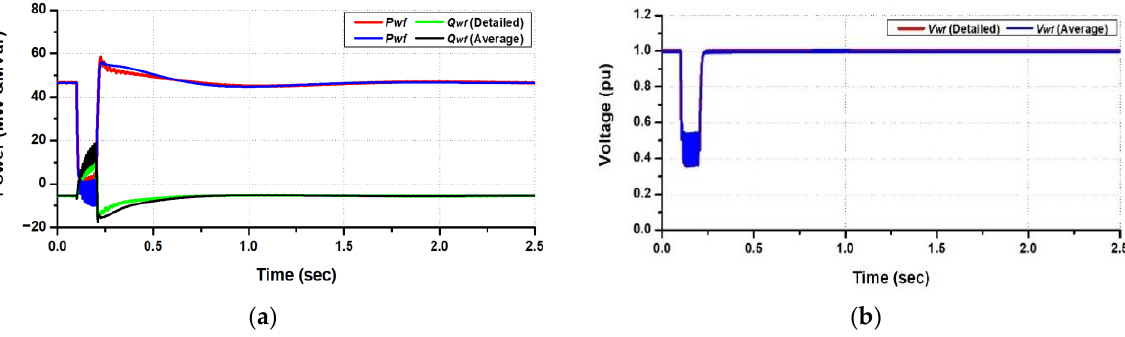
Figure 24. Power output and voltage performances of the wind farm at Bus B33 under the 2LG case: ( a ) Active power output of wind farm; ( b ) Voltage profile at Bus B33.